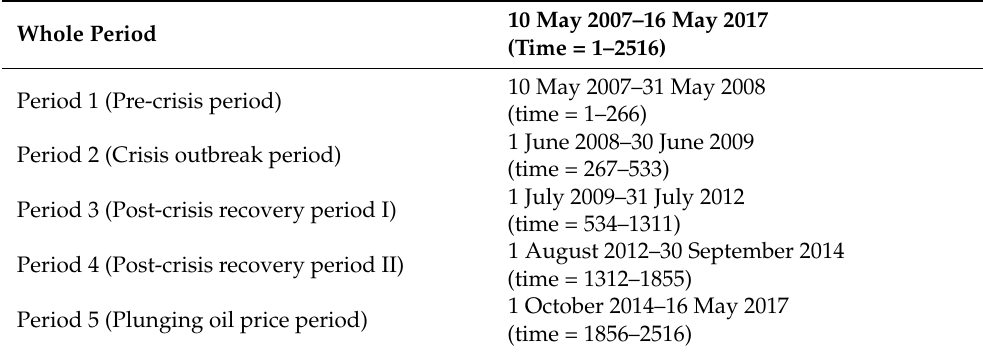
Figure 1. index_sp (S&P 500) and index_oil (USO multiplied by 50). Notes: Daily oil index (USO) multiplied by 50 and stock index (S&P 500) from 10 May 2007 to 16 May 2017 where the vertical axis is measured in U.S. dollars and time in the horizontal axis represents the date where time 1 corresponds to 10 May 2007, time 500 to 13 May 2009, time 1000 to 6 May 2011, time 1500 to 3 May 2013, time 2000 to 29 April 2015, and time 2500 to 24 April 2017, respectively. Thus, while we use the daily VRP of stock and oil returns between 10 May 2007 and 16 May 2017 to reflect the changes in economic phases, we divide the entire period into five sub-periods and investigate whether and how the VRP of stock and oil are related in each period. The sub-periods are listed in Table 1. Table 1. Periods and corresponding dates/time.